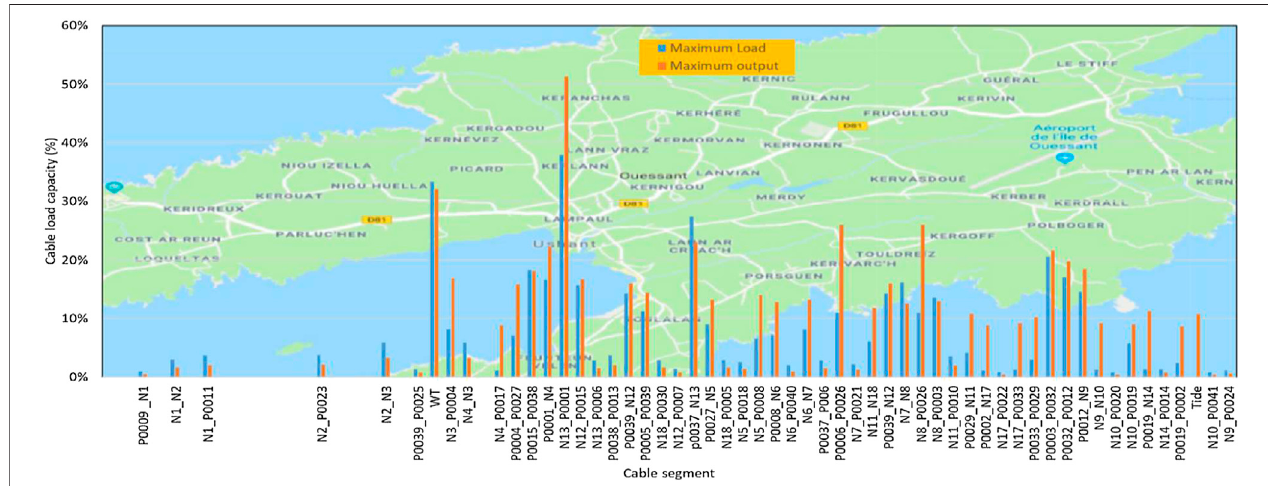
FIGURE 15 | Cable used capacity under maximum load demand and maximum renewable energy generation power output (case 2).